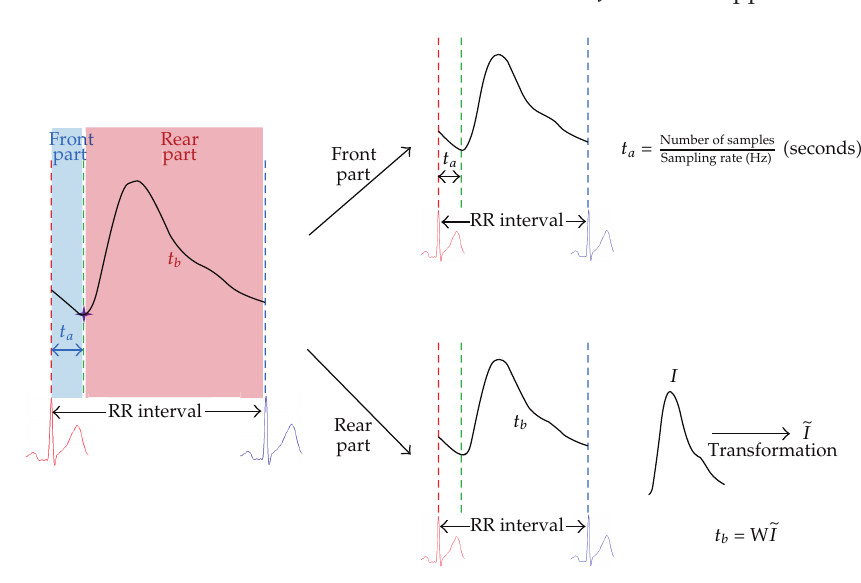
Figure 2: Single PPG pulse processing to estimate